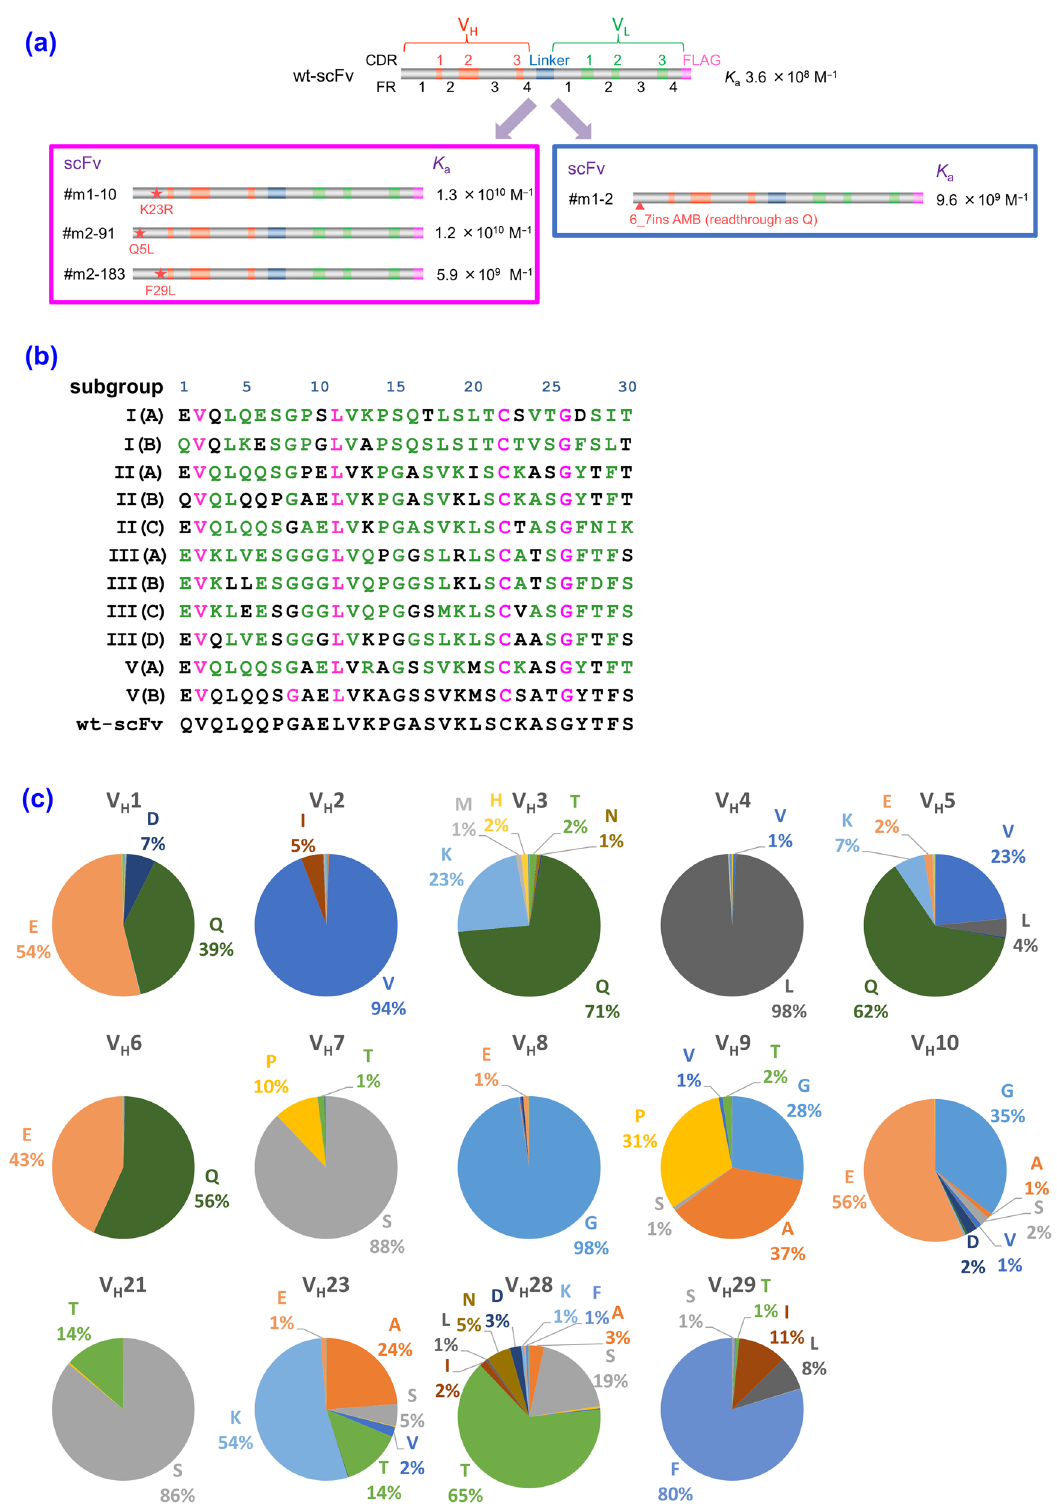
Figure 1. Backgrounds of the designed mutagenesis targeting the V H -FR1 performed in this study. ( a ) Selected data of our previous CAP-based antibody-breeding experiments with scFvs against cortisol 7 . A schematic illustration of the primary structures and K a values of wt-scFv and improved scFvs having only a single amino acid substitution or insertion in the V H -FR1. In wt-scFv, the V H and V L domains were combined via a linker sequence VSS(GGGGS) 3 T. ( b ) The most common amino acids found at the positions 1 – 30 in V H (i.e., the V H -FR1) in different subgroups as defined by Kabat et al. 18 . The frequency of appearance of each residue is shown with different colors 27 : magenta, invariant (> 95%) and common in all subgroups; green, “subgroup-specific residues” that are invariant within the relevant subgroup(s). The V H -FR1 amino acid sequence of wt-scFv is also shown for comparison. ( c ) The frequency of amino acids at the positions 1–10, 21, 23, 28, and 29 in V H , compiled for 1,820 antibodies that were available in the Kabat database 18,26 . The detailed data listing for the positions 1–30 is available in Supplementary Table